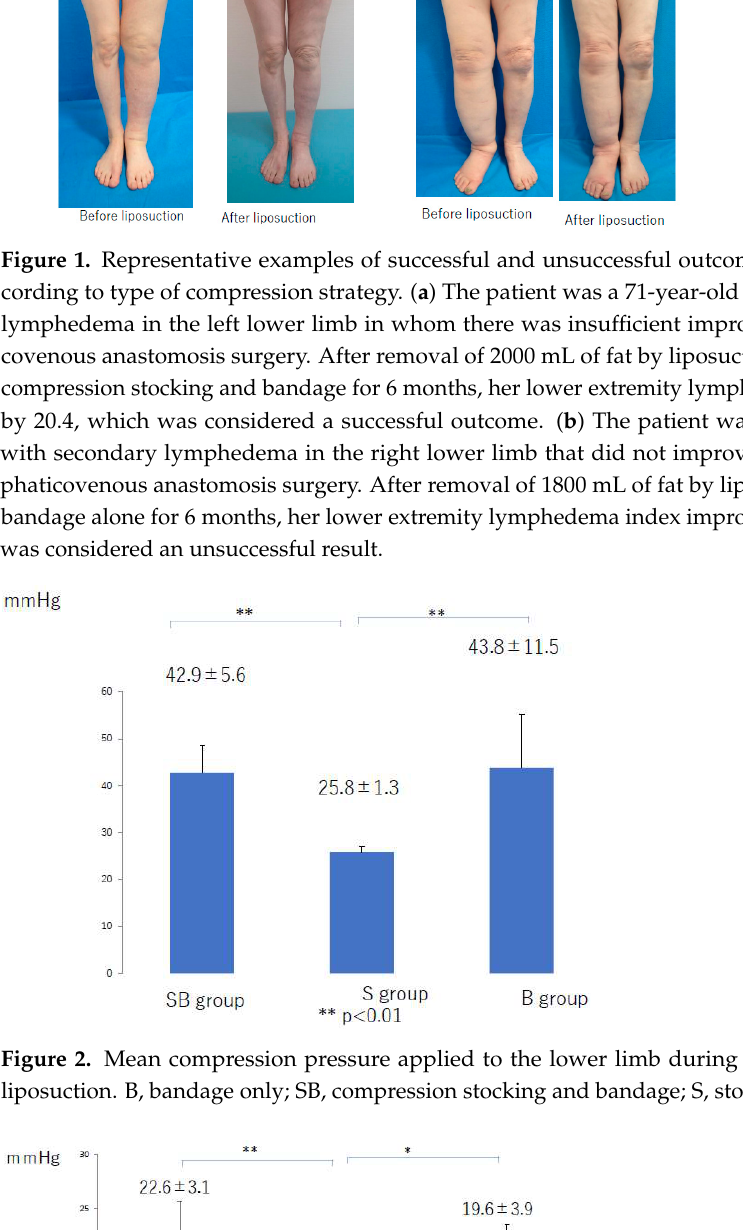
Figure 2. Mean compression pressure applied to the lower limb during the first 6 months after lip- osuction. B, bandage only; SB, compression stocking and bandage; S, stocking only.